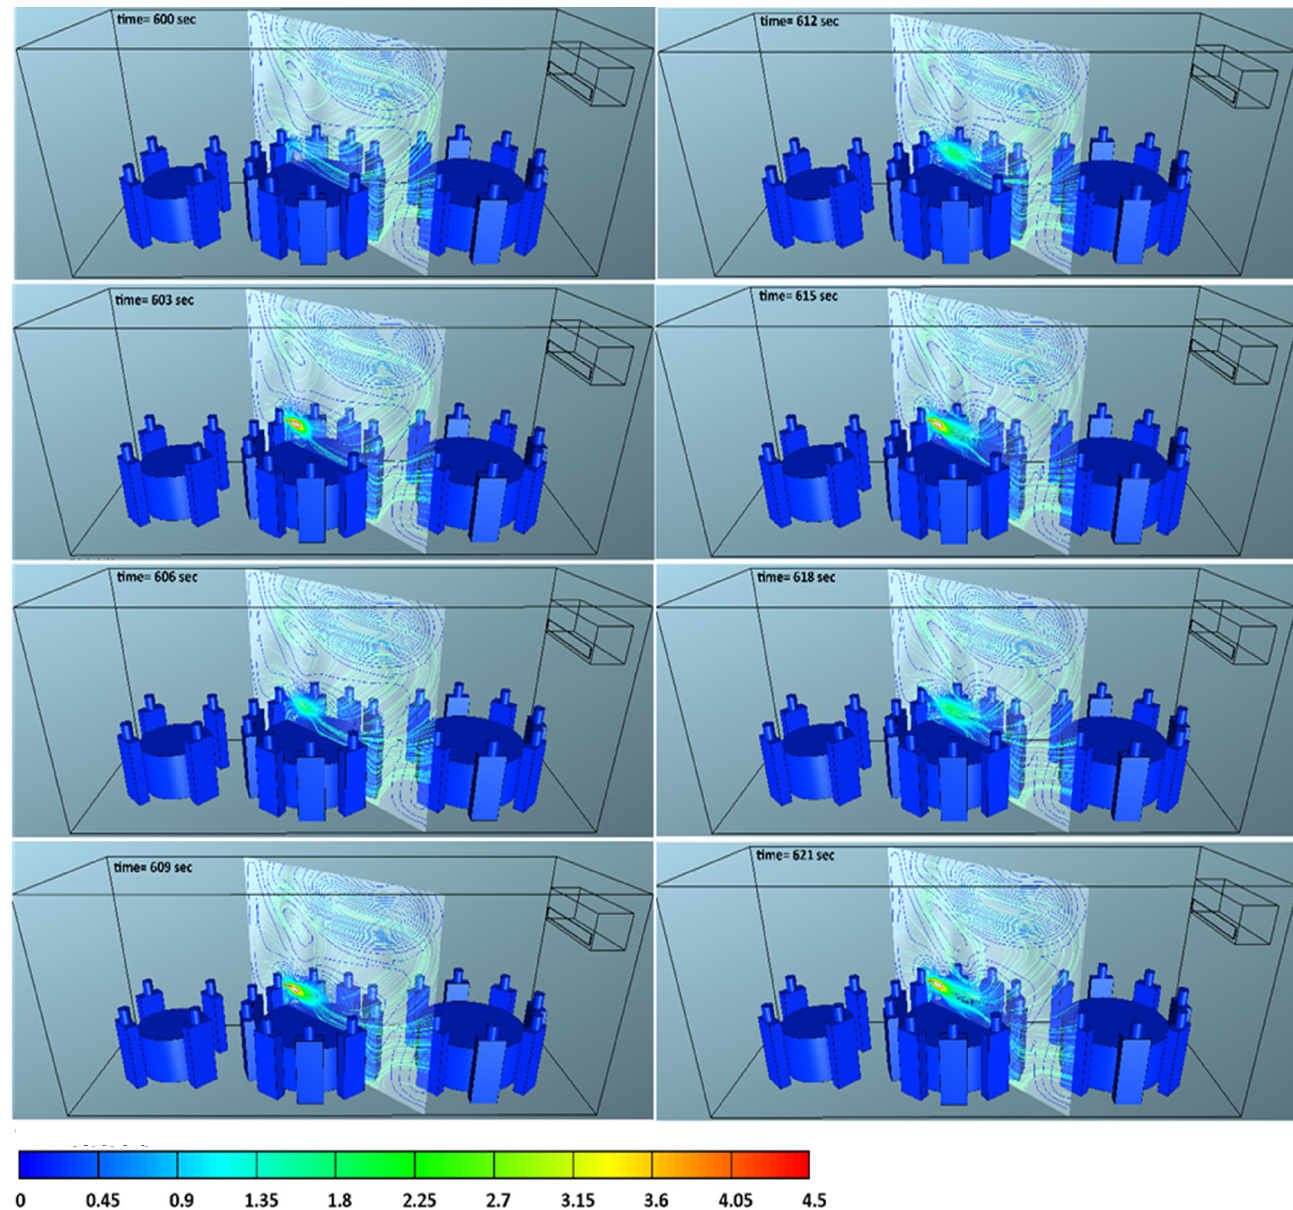
Figure 15. The effect of sneezing on airflow streamlines velocities at different time steps, case-2.